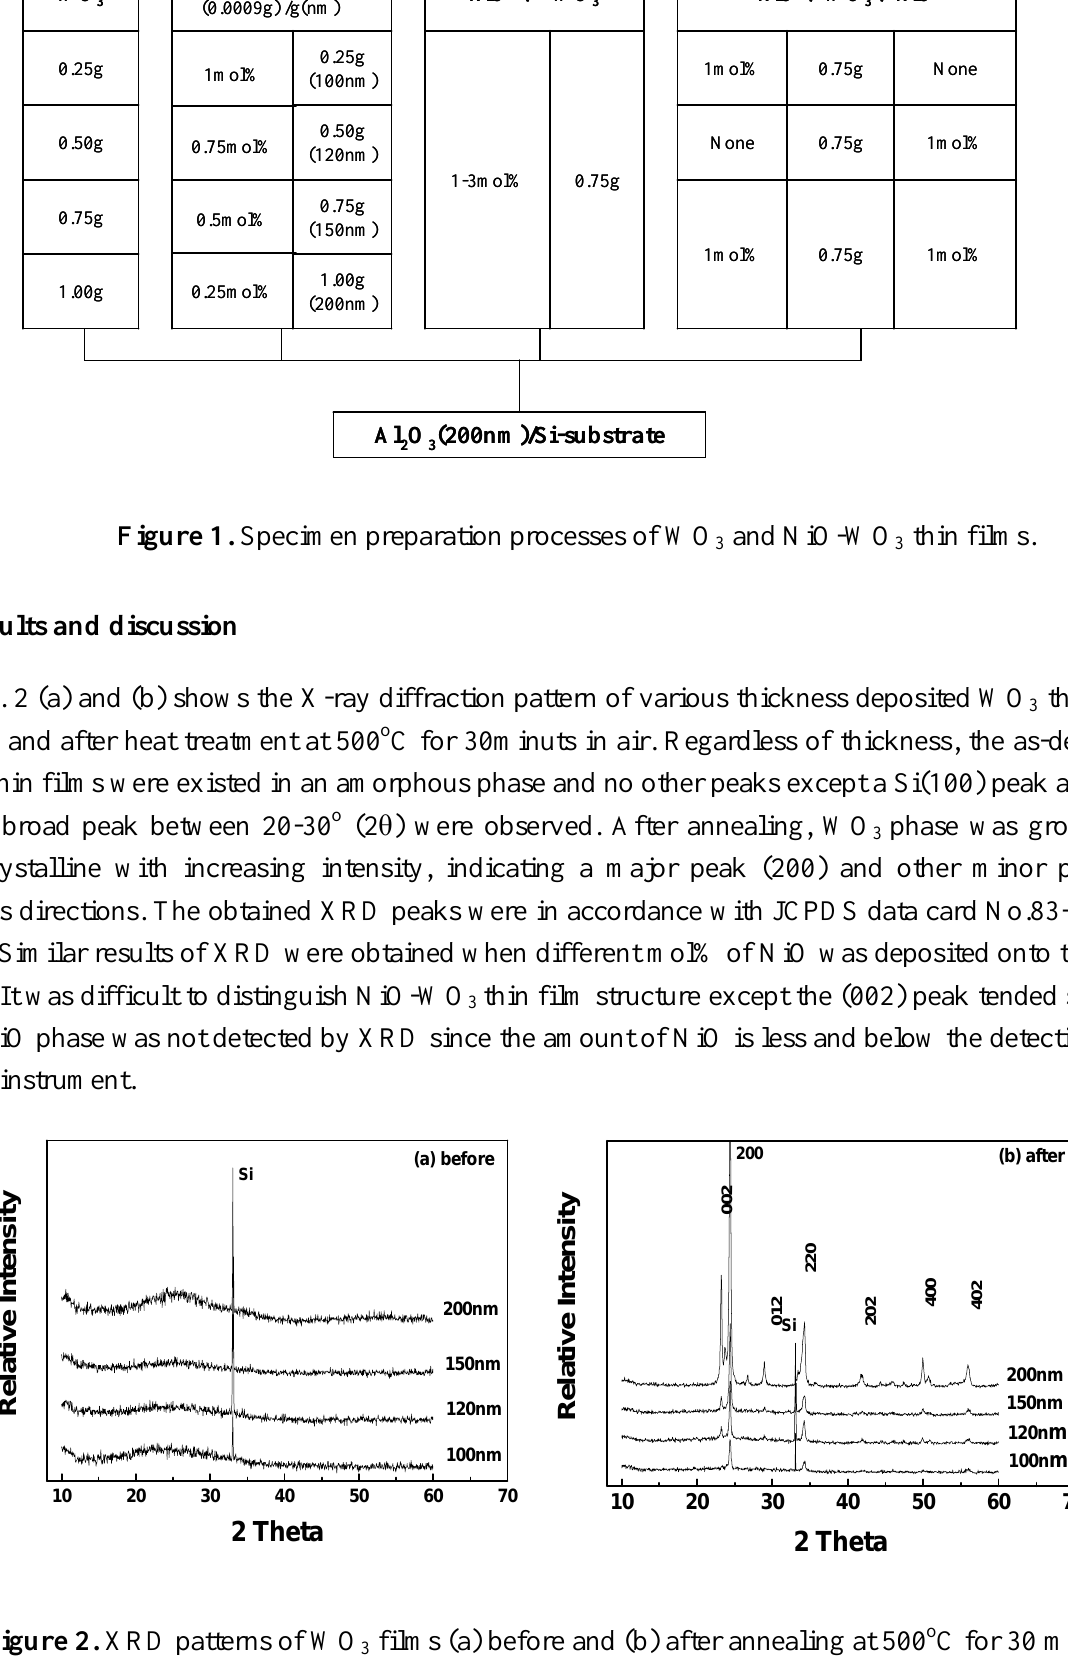
films (a) before and (b) after annealing at 500 o C for 30 Figure 2. XRD patterns of WO 3